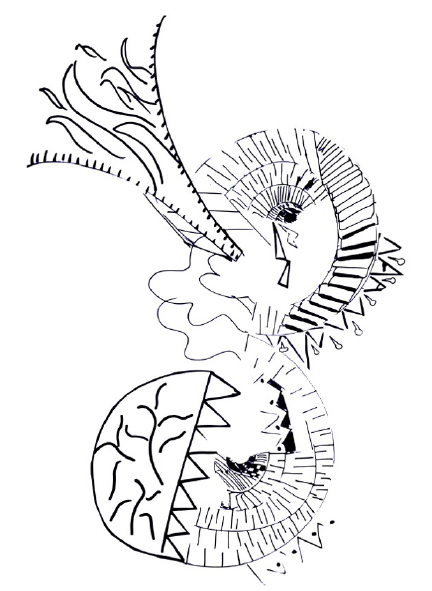
Figure 3. The Screen